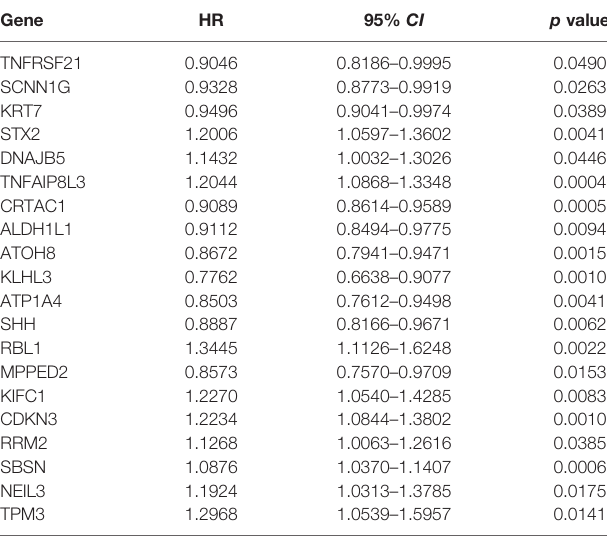
TABLE 1 | Univariate Cox regression analysis of differential genes in bladder cancer. Gene